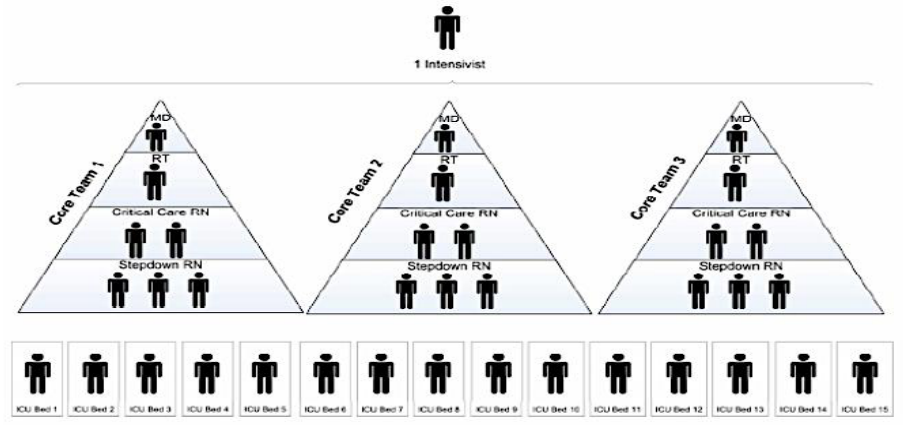
Figure 4. ICU tiered staffing strategy for COVID-19 pandemic; (1 ICU-trained nurse: 2 re-assigned nurses: 4 patients). This model can be expanded on a needs basis as pandemic scales up.